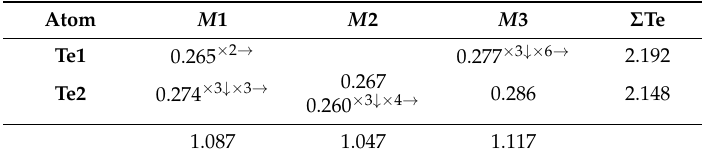
Figure 2. The crystal structure of spiridonovite. M (Cu,Ag) sites and Te atoms are given as white and black circles, respectively. The tetrahedral coordination of the M sites is shown as isolated polyhedra. The unit cell and the orientation of the structure are outlined. Table 7. Bond valence sums (v.u.) for spiridonovite.